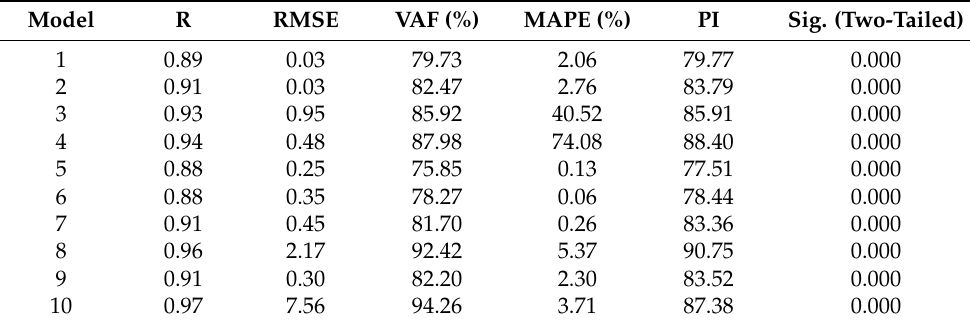
Table 6. Statistical parameters for performance of SRA